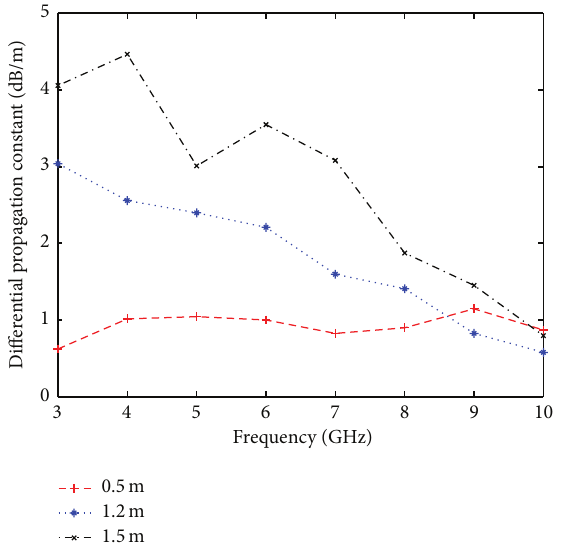
Figure 5: Differential propagation constants as a function of